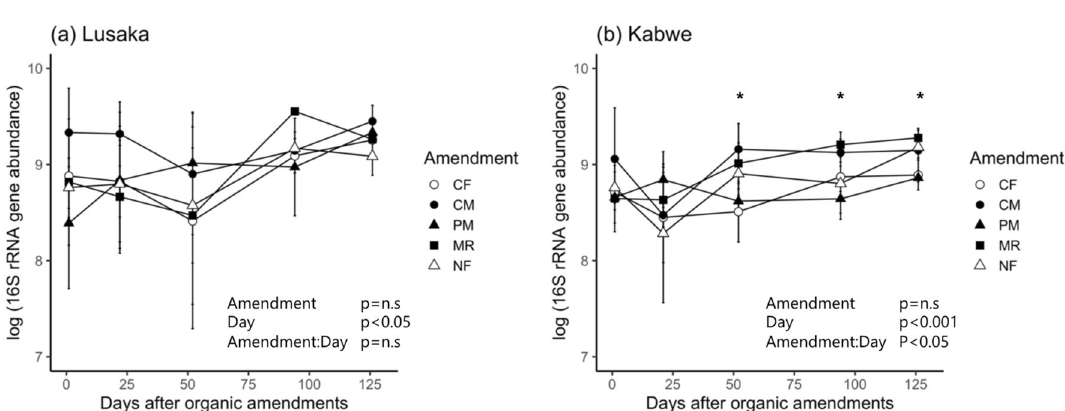
Figure 4. Relationship between CO 2 emission rates and soil moisture at the ( a ) Lusaka and ( b ) Kabwe sites. Pearson’s correlation coefficients between the log-transformed CO 2 emission rates and soil moisture are shown in the top left corner of each panel. CF: chemical fertilizer amendment, CM: cattle manure amendment, PM: poultry manure amendment, MR: maize residue amendment, and NF: no fertilizer amendment.